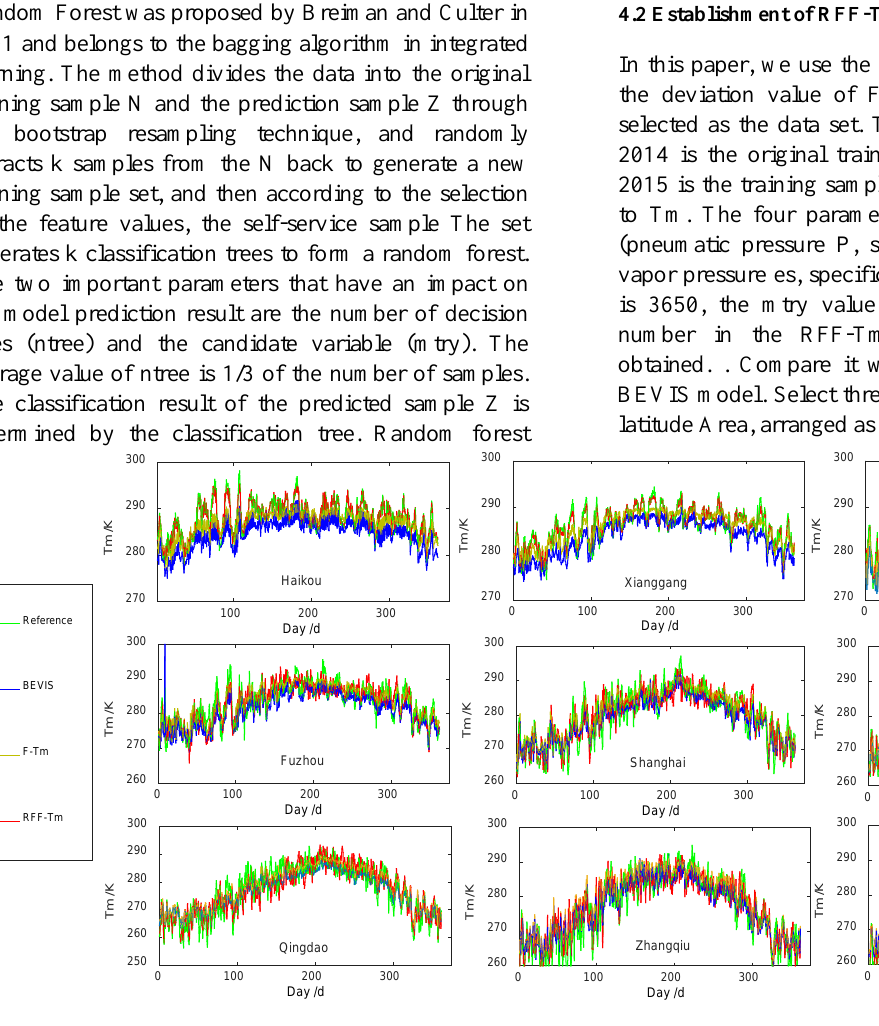
Fig 3. Contrast error of three models in